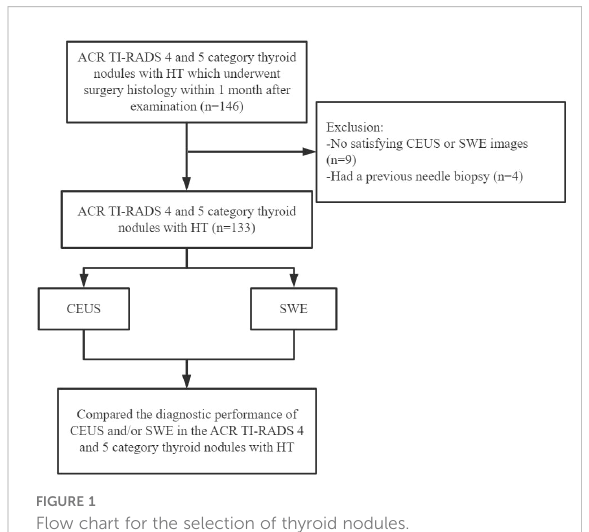
FIGURE 1 Flow chart for the selection of thyroid